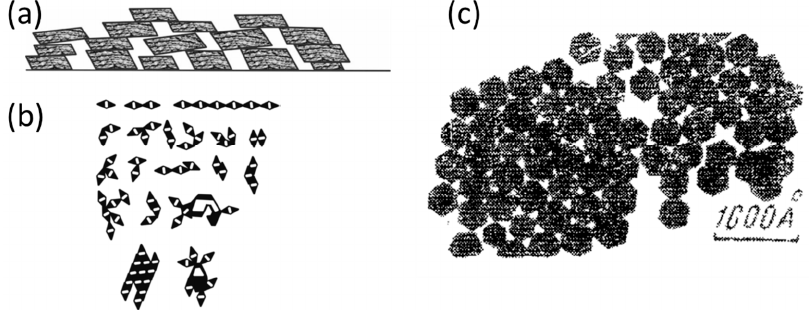
Figure 2. Examples of early reports on the formation of “block-like” and/or “mosaic” crystals and self-assemblies of nanocrystals with mutual orientation. ( a ) Schematic illustration of particle mediated growth of crystals via oriented attachment of submicron-sized building blocks (Shubnikov scheme: based on experimental observation of growth process of potassium alum crystals) [10,13]. ( b ) Schematic illustration of oriented assembly of colloidal sulfur particles in solution (according to the Yushkin model) [14]. ( c ) Electron microscopy image of self-assembled PbSe particles on a Si substrate. Cuboctahedrally shaped nanoparticles assembled in close-packed monolayers and oriented with mainly { 111 } faces parallel to the substrate [32].